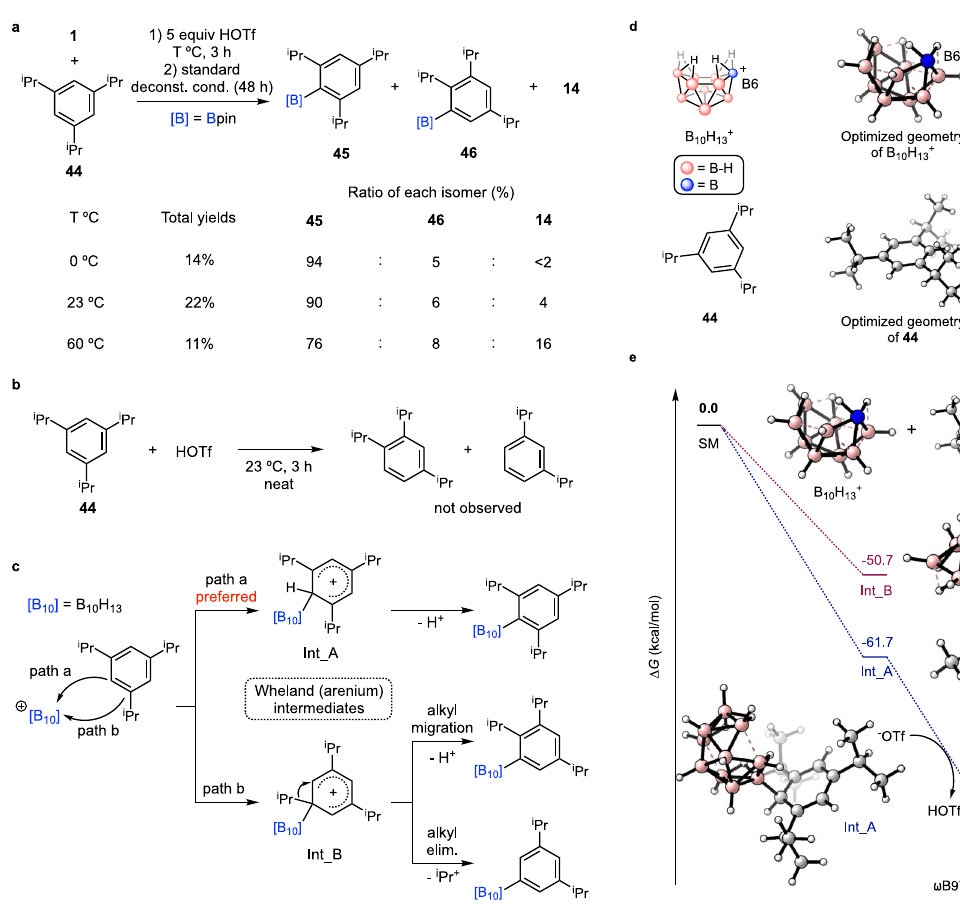
Fig. 4 | Borylation of 44 and DFT computational studies. a Borylation of 44 giving three isomers ( 45 , 46 and 14 ) as the products. b Reaction of HOTf and 44 . c Two pathways in the regioselective step in borylation of 44 . d DFT-optimized geometries of B 10 H 13 + and 44 and visualized LUMO of B 10 H 13 + and HOMO of 44 .